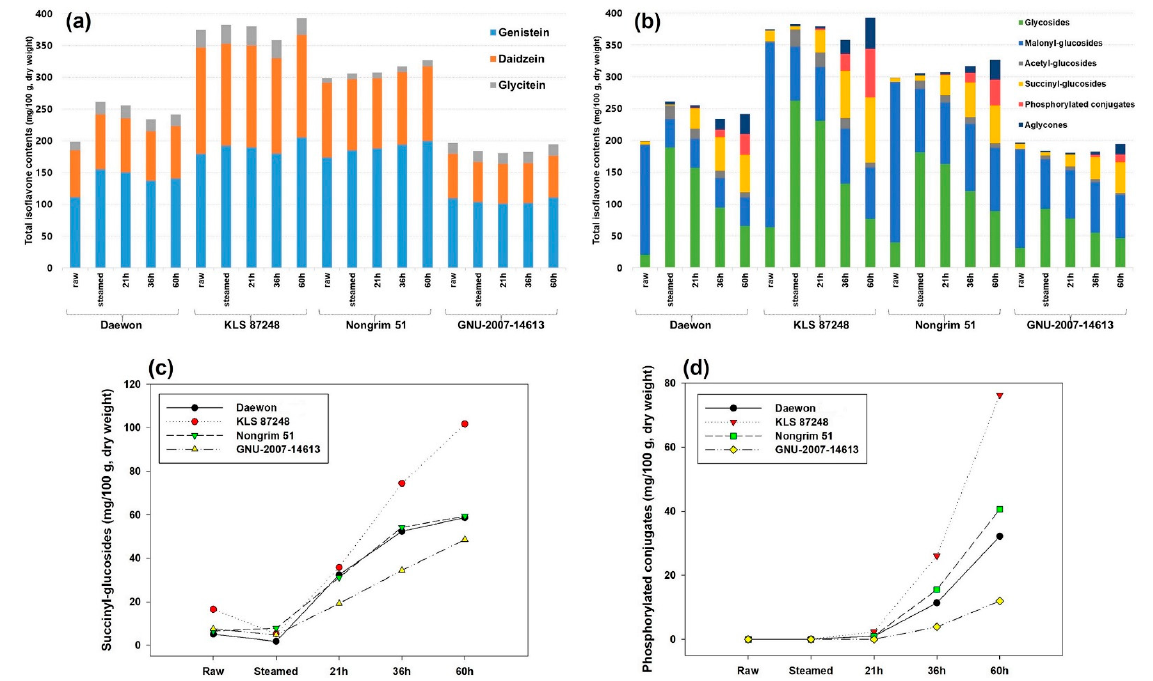
Figure 3. Comparison in total isoflavones content (mg/100 g, dry weight) based on ( a ) aglycone types or ( b ) derivatives as well as changes in total content of new ( c ) succinyl ‐ glucosides and ( d ) phosphorylated conjugates from soybean samples (Daewon, KLS 87248, Nongrim 51 and GNU ‐ 2007 ‐ 14613) according to steamed and fermented (after 21, 36 and 60 h with B. subtilis AFY ‐ 2) con ‐ ditions.